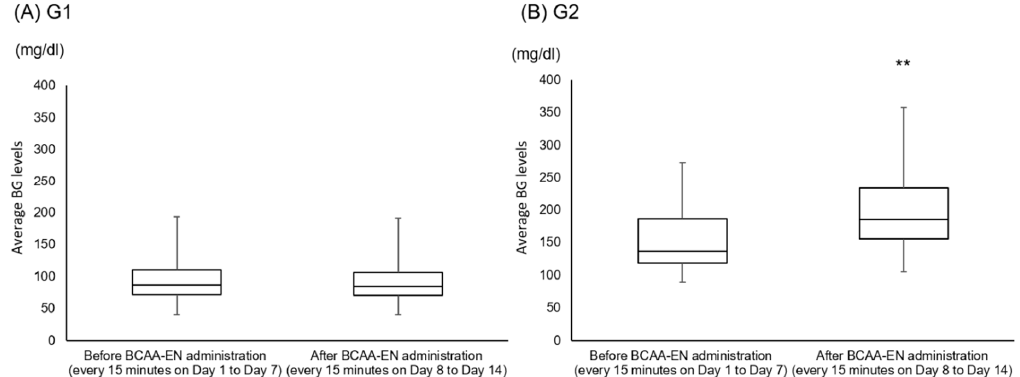
Figure 2. Average BG levels before (every 15 min in the nighttime between days 1 and 7) and after (every 15 min in the nighttime between days 8 and 14) BCAA-EN administration in patients with cirrhosis. The average BG levels did not significantly change after BCAA-EN administration in G1 (before 91.9 ± 29.0 mg / dL; after 89.0 ± 24.3 mg / dL). ( B ) However, the average BG levels significantly increased after BCAA-EN administration in G2 (before 153.6 ± 43.3 mg / dL; after 200.9 ± 59.7 mg / dL). G1, group 1: patients whose nocturnal BG levels were ≥ 200 mg / dL; G2, group 2: patients whose nocturnal BG levels were < 200 mg / dL; BCAA-EN, branched-chain amino acid-enriched nutrient; BG, blood glucose. Asterisks indicate statistically significant di ff erences between groups 1 and 2 (** p <